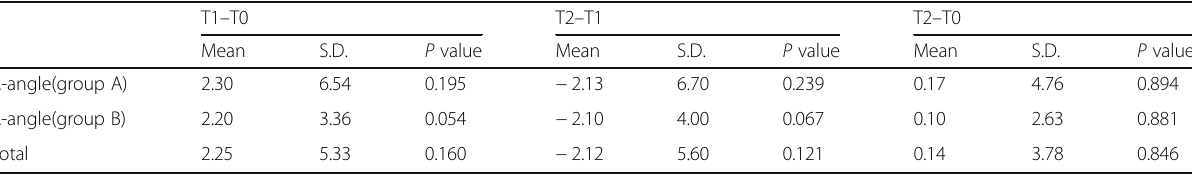
Table 2 Positional changes of the condyle on the axial view